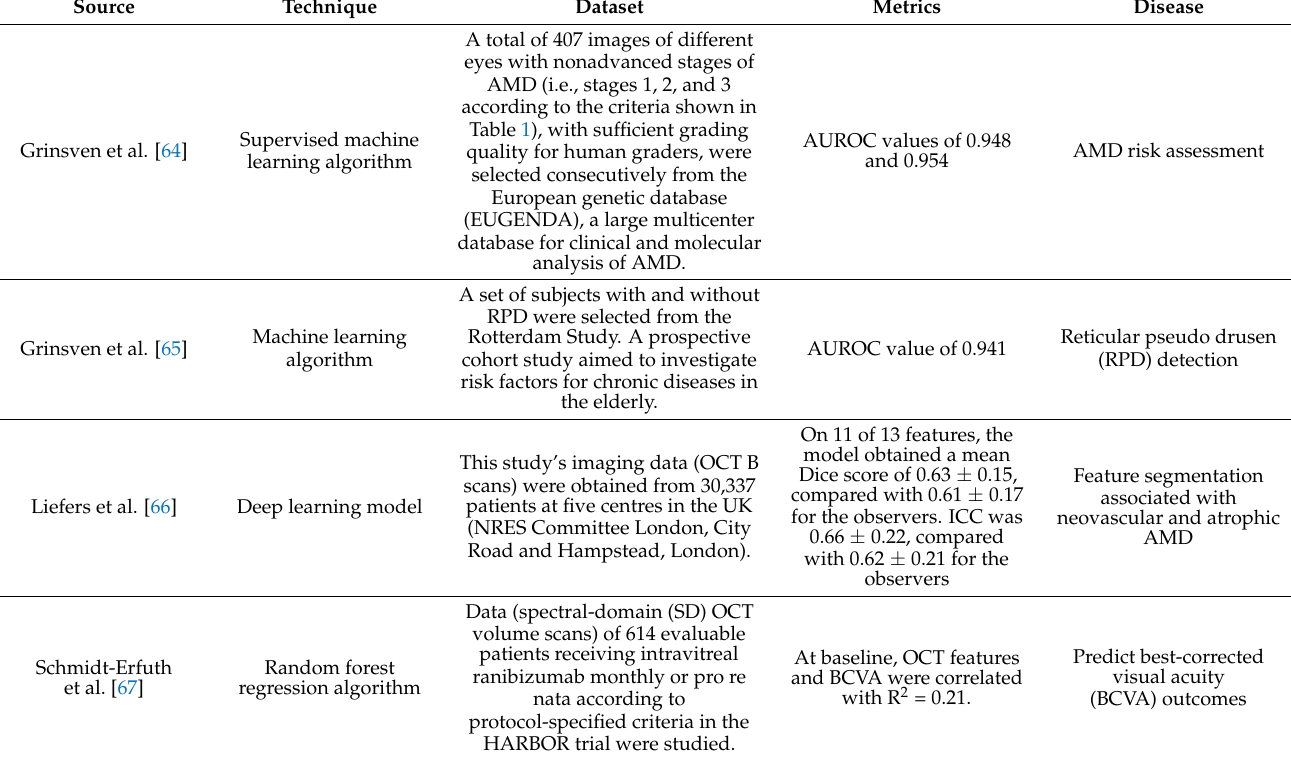
Table 2. The summarized review of AI techniques for